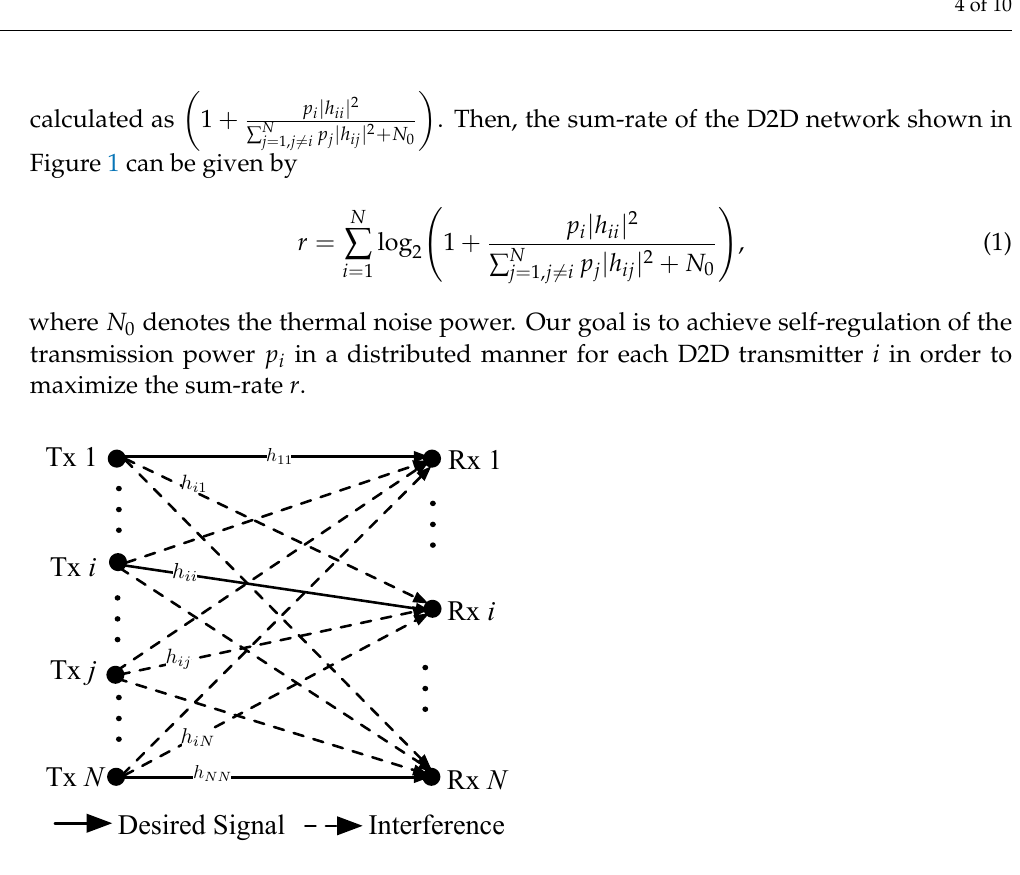
Figure 1. An example of an overlay D2D communication network with N D2D